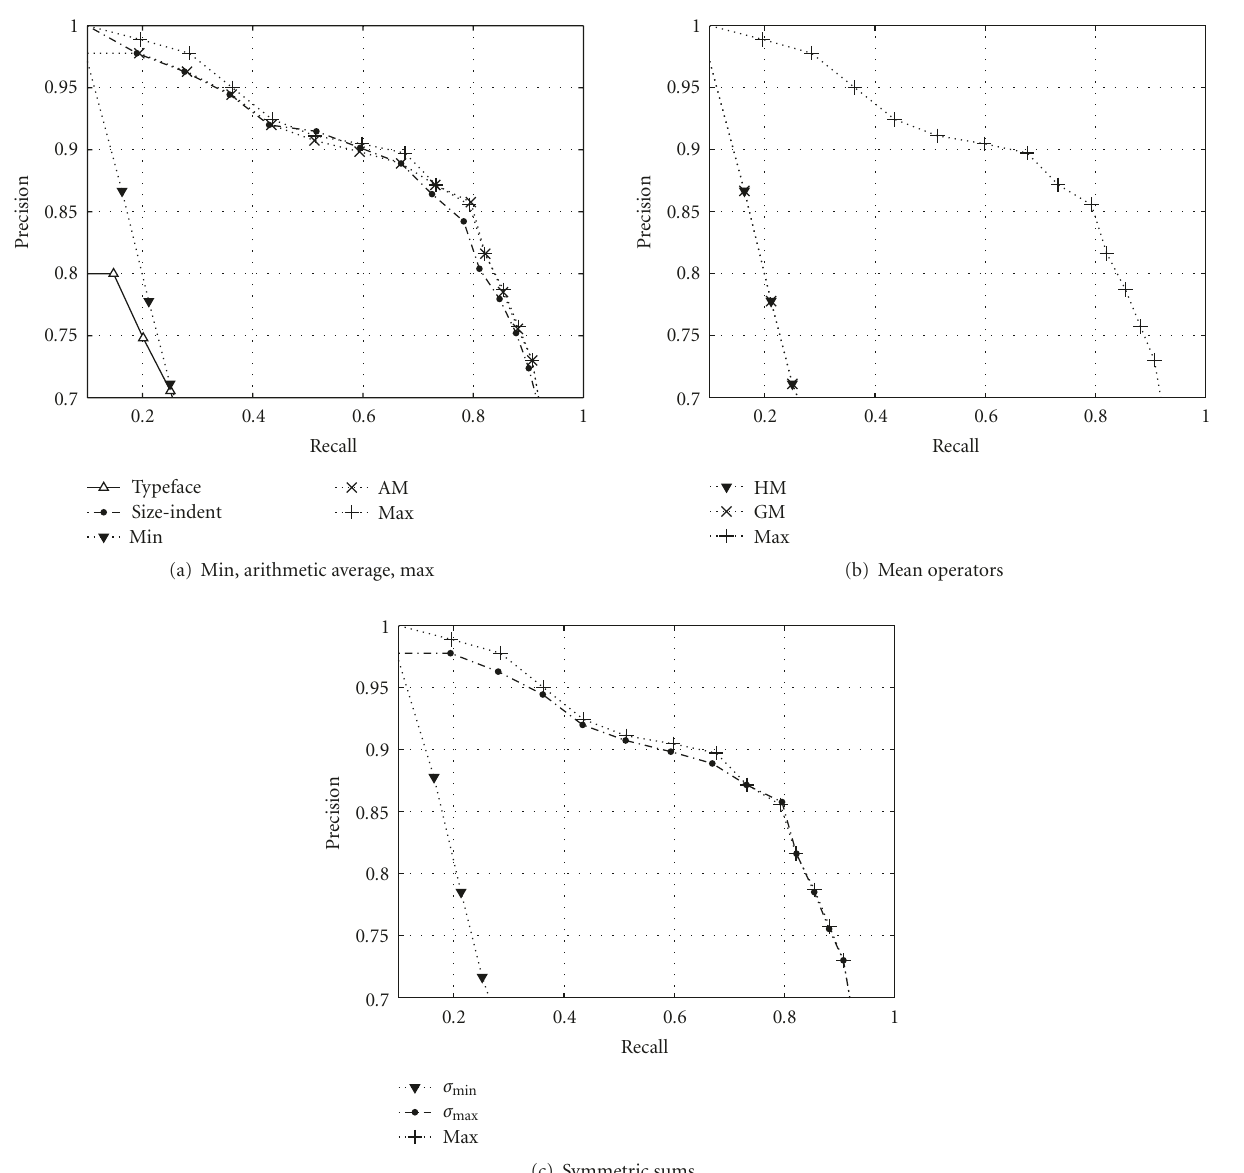
Figure 13: Precision-recall curves for aggregation of size, indent, and attribute features using various aggregation